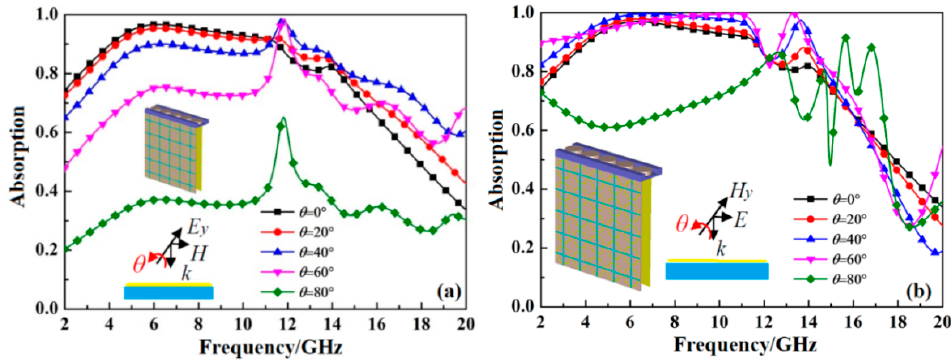
Figure 8. The absorption at different incident angles when the rotatable metal plate is parallel to the rest of the layers, ( a ) TE mode, ( b ) TM mode.